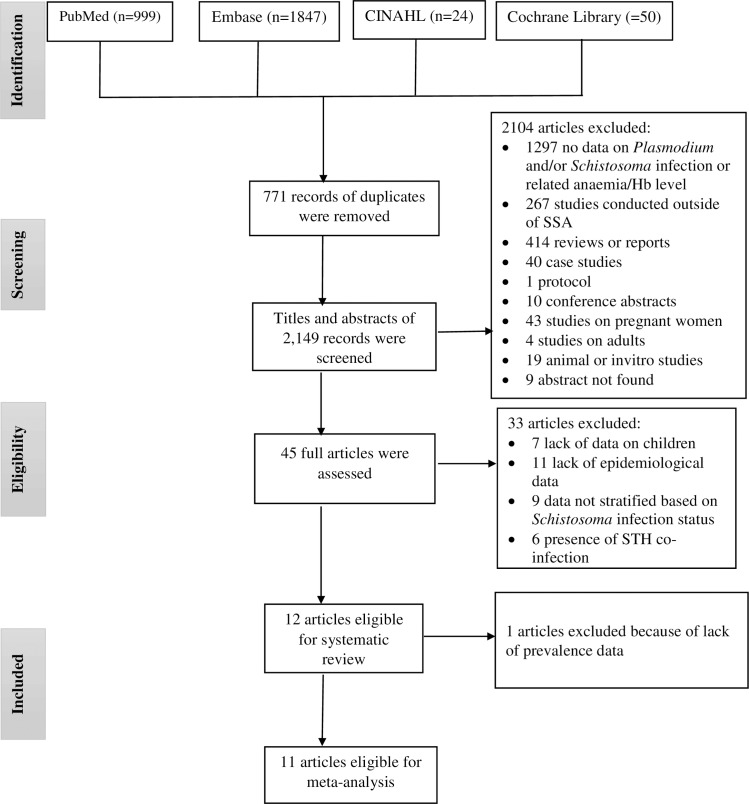
PRISMA diagram.Flow chart for study selection. Hb: Haemoglobin; SSA: sub-Saharan Africa; STH: Soil-transmitted helminths